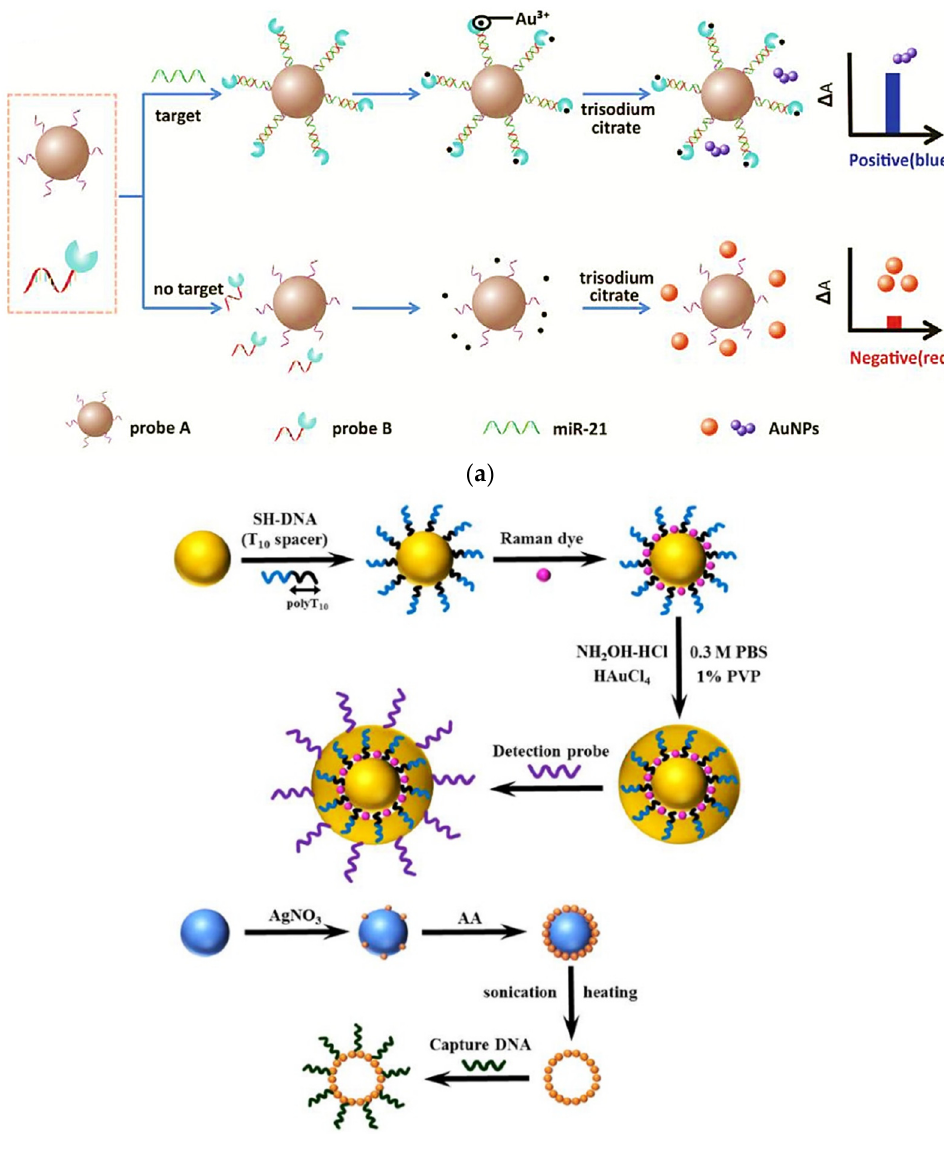
Figure 7. ( a ) Schematic diagram of MC colorimetric biosensor for miR-21 detection [143], and ( b ) schematic illustration of Synthetic procedures of Raman dye-coded Au-NPs using DNA-modified AuNPs as templates and the biotemplating synthesis strategy of AgHMSs using bacteria as template (blue sphere) and ascorbic acid (aa) as Ag reductant agent [75], ( a ) reprinted with permission from Elsevier, and ( b ) reprinted with permission from American Chemical Society.